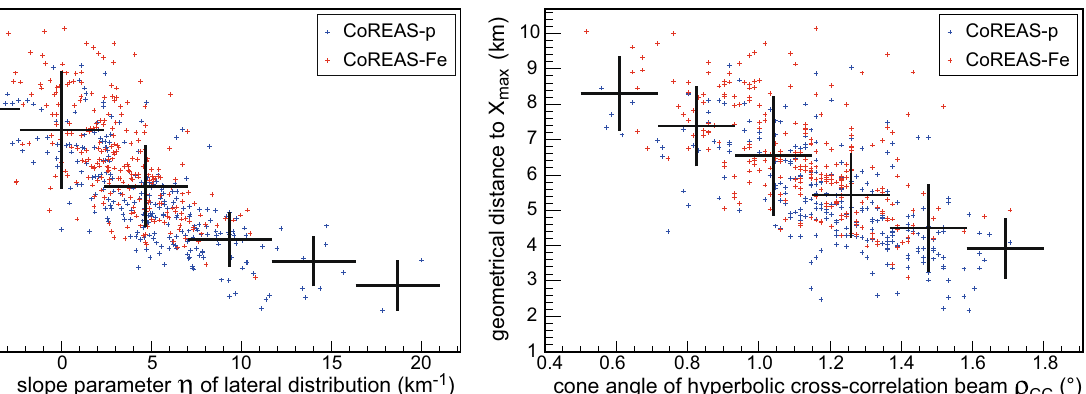
Fig. 17 Correlation of the lateral slope parameter η (left) and of the wavefront cone angle ρ (right) of the CoREAS end-to-end simulations (with noise) with the geometrical distance to the shower maximum for